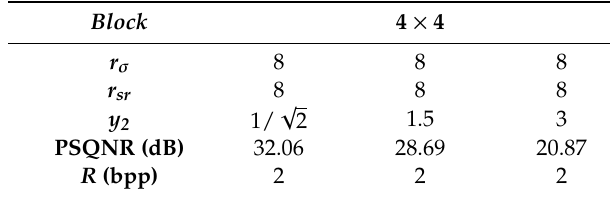
Table 2. Performance comparison of the block truncation coding algorithm using optimal and non-optimal binary quantizers, applied to the monochrome image of Lena.